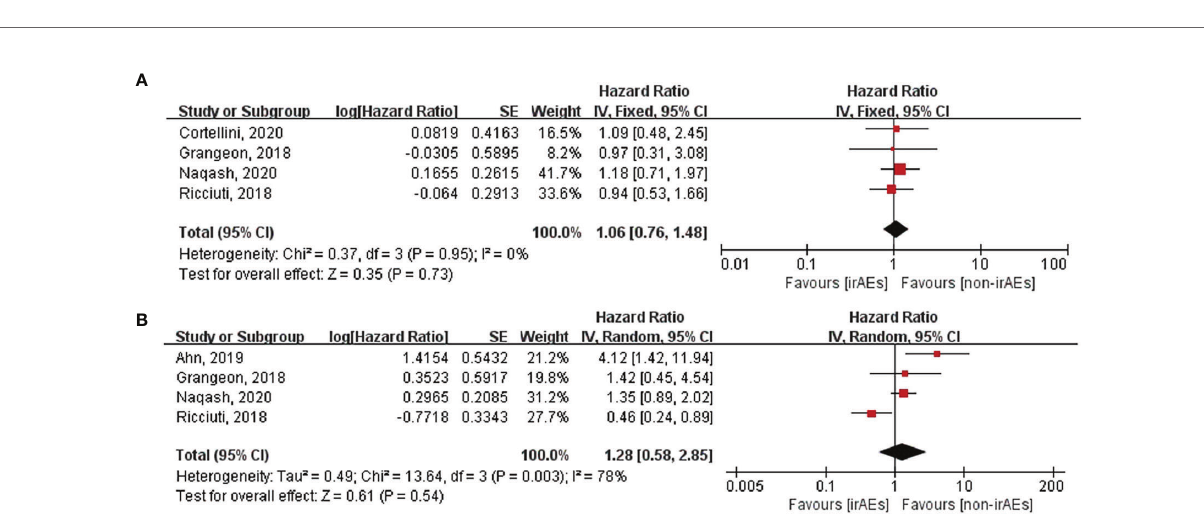
FIGURE 6 | Forest plot of the association between the occurrences of different irAEs types and OS. (A) hepatobiliary irAEs; (B) pulmonary irAEs. OS, overall survival; irAEs, immune-related adverse events; non-irAEs, non-immune-related adverse